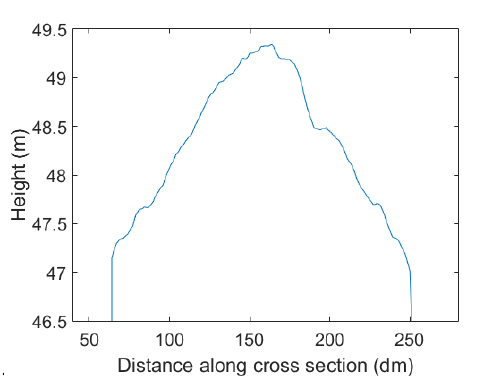
Figure 4. (a) Results of Canny edge detection, and (b) the refined edges using scan line segmentation for a hipped roof with dormer windows.